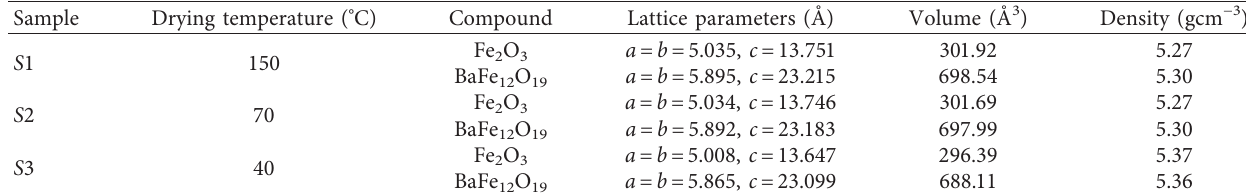
Table 1: The lattice parameters and density of the products. Sample Drying temperature ( °